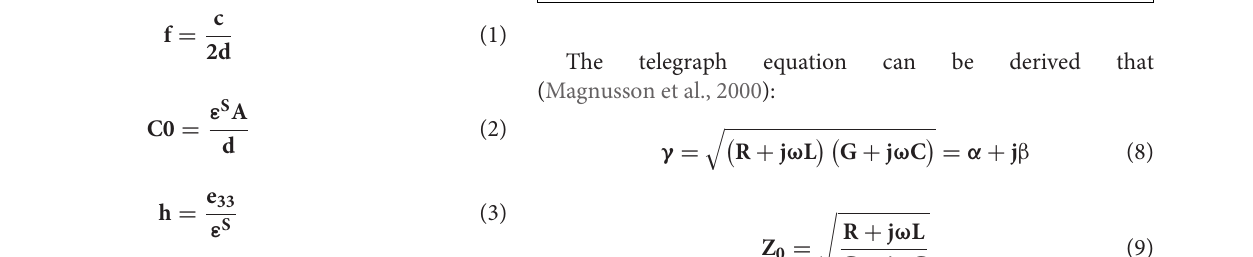
FIGURE 2 | The transmission line model of